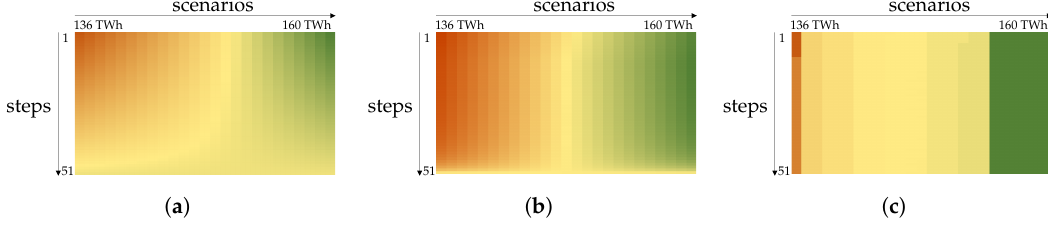
Figure A2. Ratios and prices for Figure 10a, model run EM 13 (Scenarios: 136 TWh–160 TWh), where all profiles and prices are constant. ( a ) ratio 1; ( b ) ratio 2; ( c ) scenario prices.